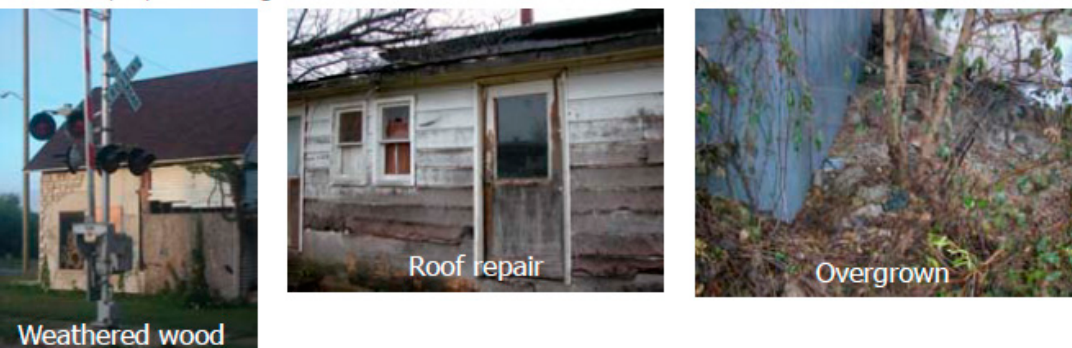
Figure 7. Weathered wood, roof disrepair, and overgrown vegetation provide evidence of neglect in abandoned houses. Photography: K. Sandin.